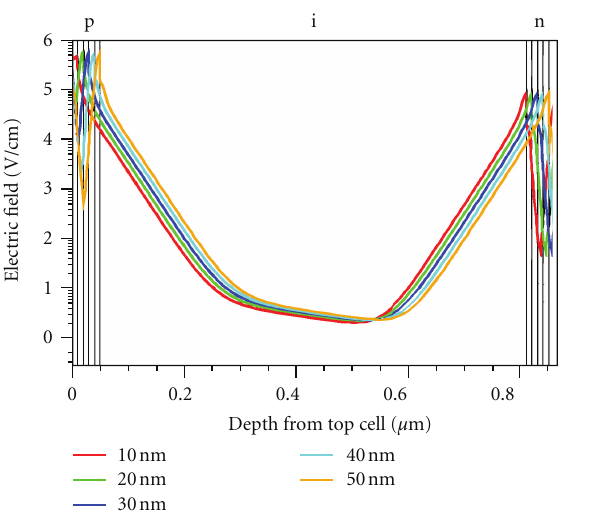
Figure 8: Electric field distribution of The a-SiGe:H solar cell device for di ff erent thickness of p-layer.